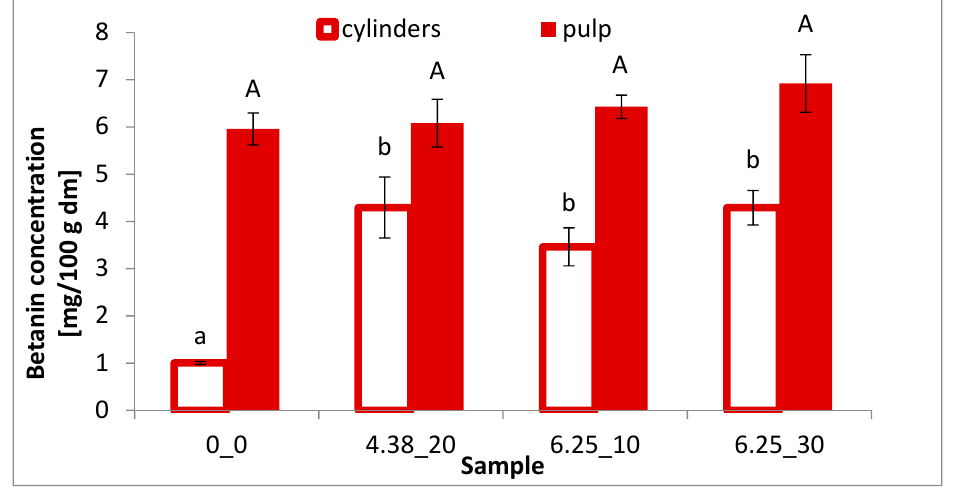
Figure 2. Betanin concentration of differently treated beetroot cylinders and pulp. The same letter (and the same letter size) on the same column means no significant difference by the Tukey test ( p < 0.05).